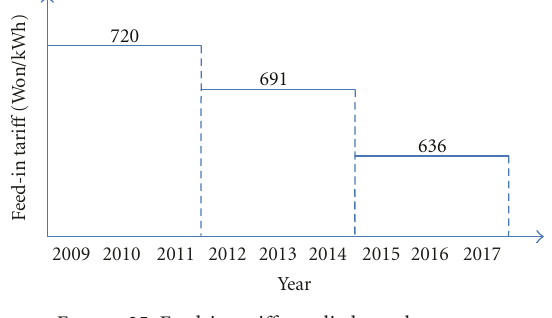
Figure 25: Feed-in tari ff s applied to solar energy.